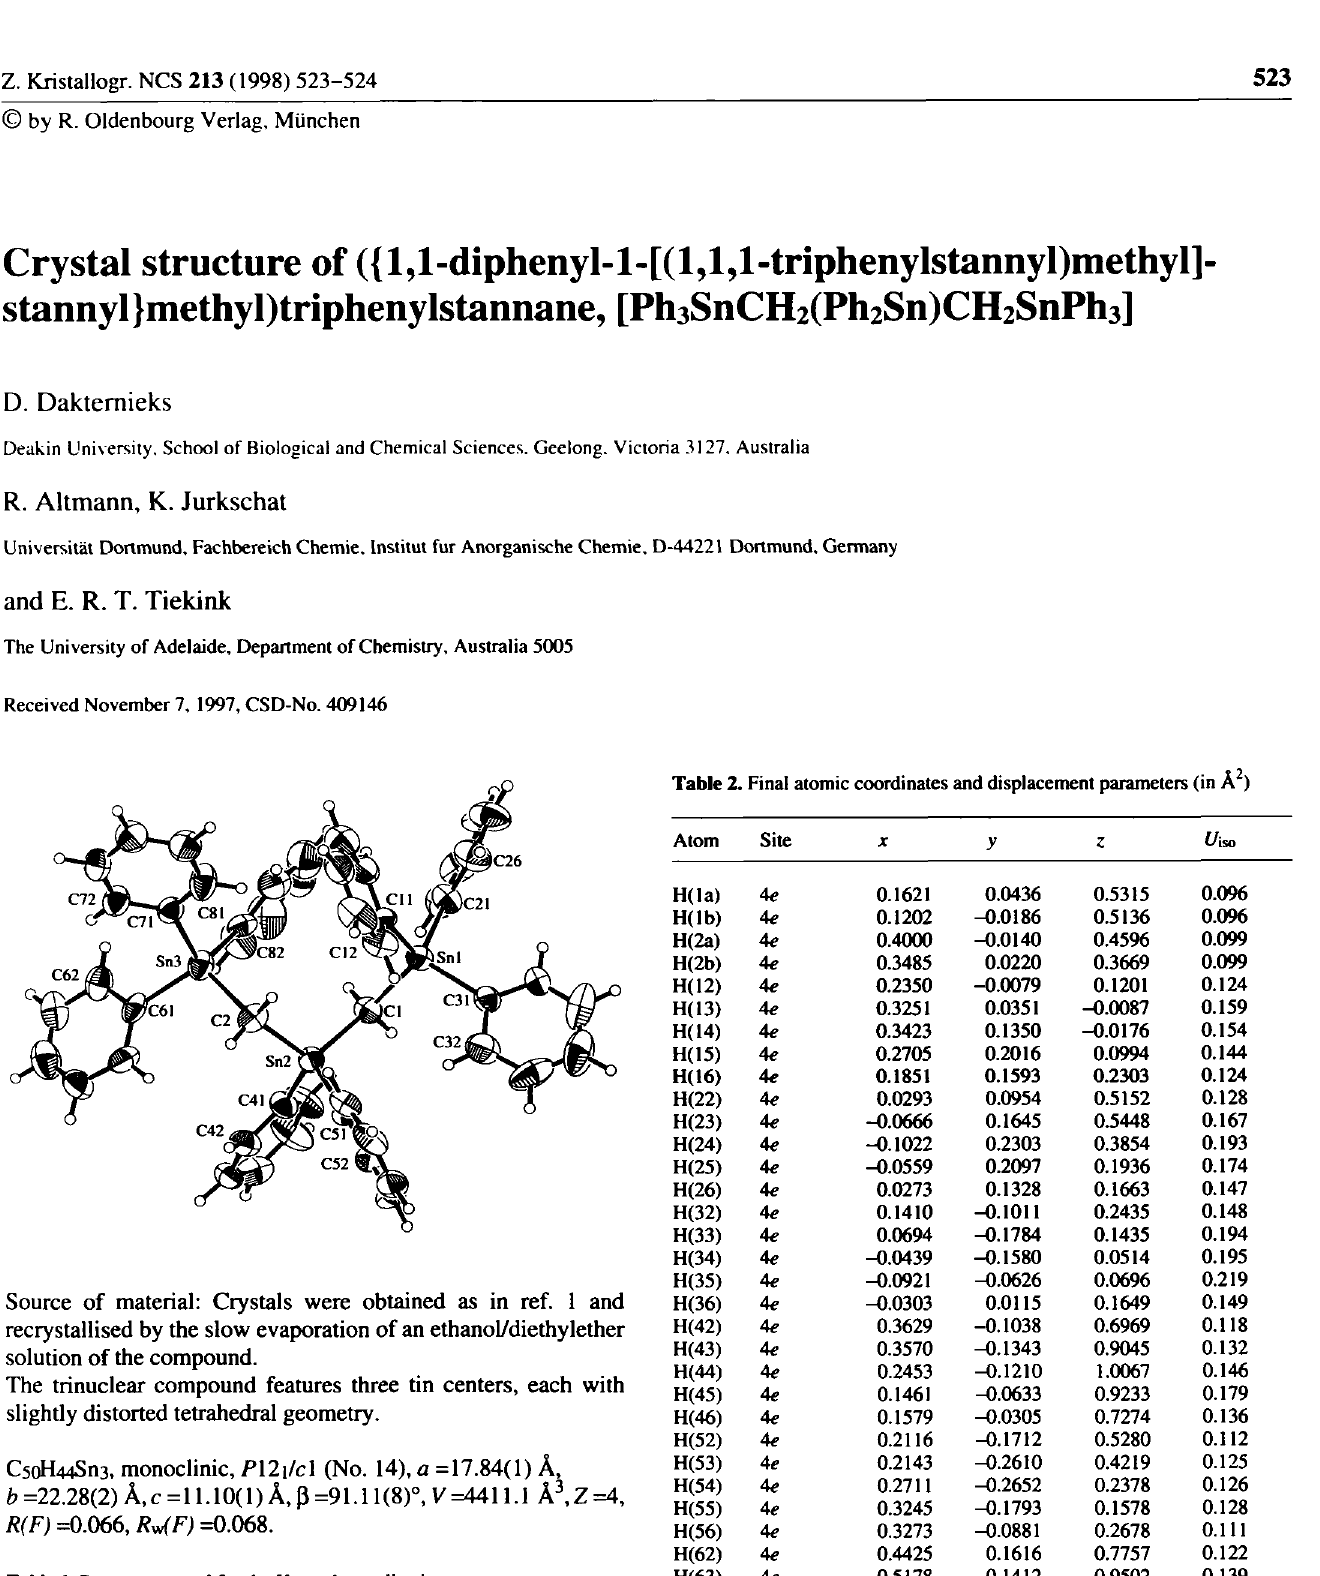
Table 1. Parameters used for the X-ray data collection